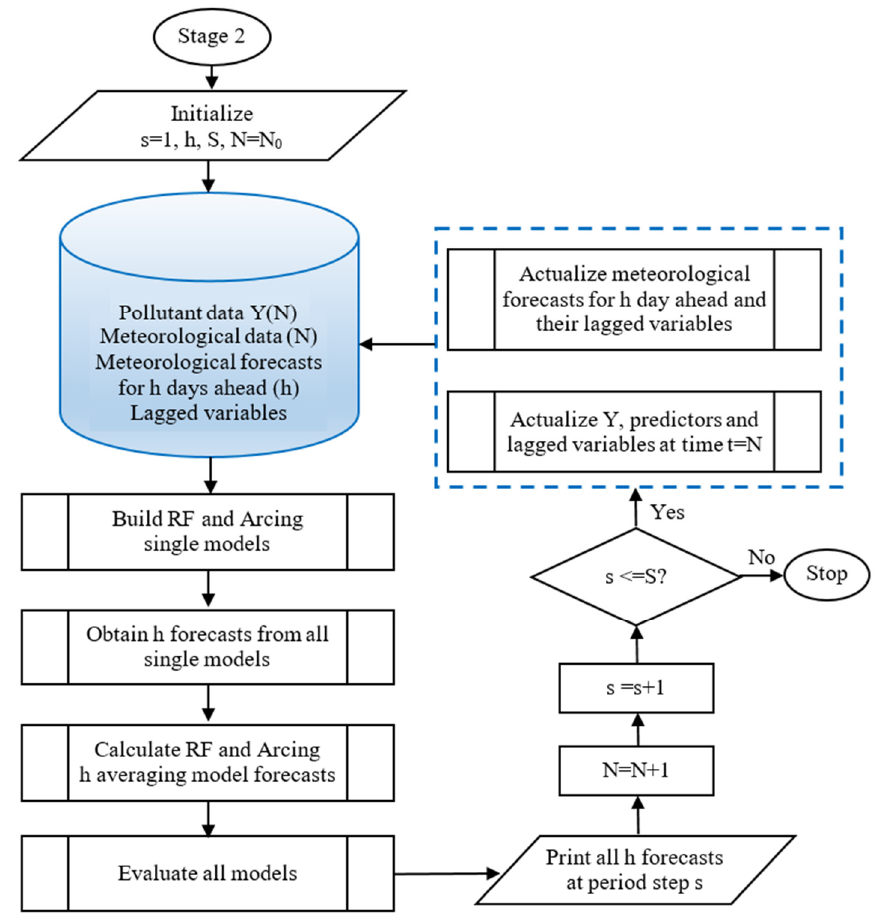
Figure 2. Flowchart of the algorithm of stage 2: Multi-step ahead forecasting.